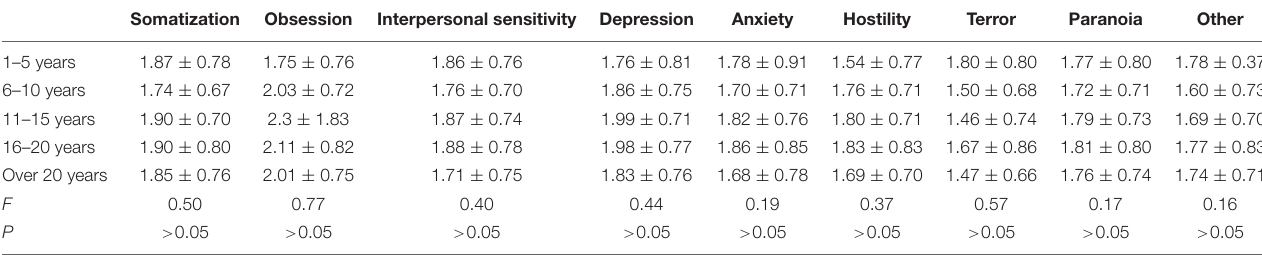
TABLE 6 | Comparison of survey results of teachers with different teaching years. Somatization Obsession Interpersonal sensitivity Depression Anxiety Hostility Terror Paranoia